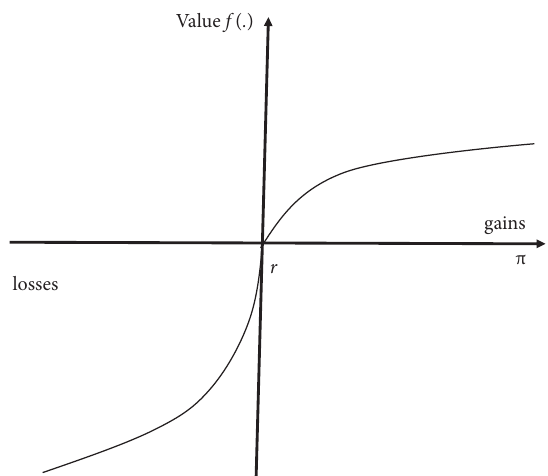
Figure 1: The curve of an S-shaped value function. Note: f ( Δπ ) is the gain-loss utility, r is the reference point, and π is the final